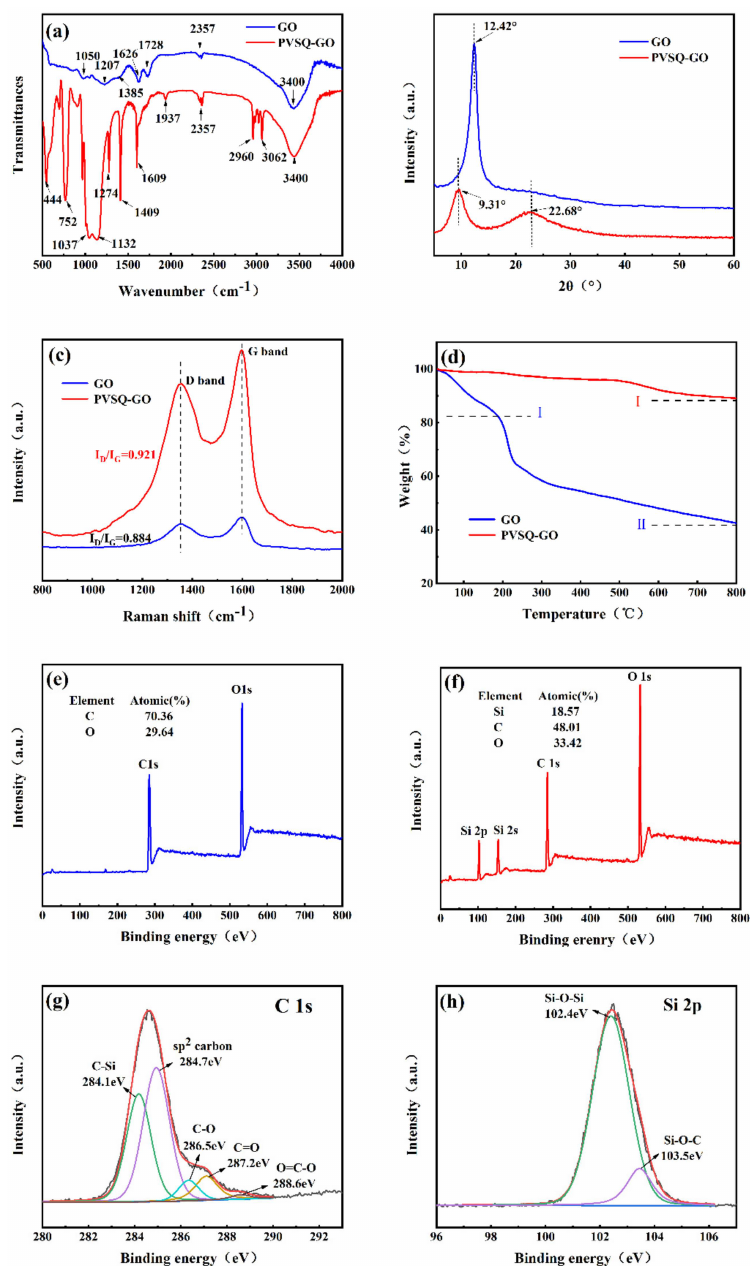
Figure 3. ( a ) FTIR, ( b ) XRD patterns, ( c ) Raman spectra, ( d ) TGA curves of GO and PVSQ-GO. ( e , f ) Survey X-ray photoelectronic spectroscopy (XPS) spectra of GO and PVSQ-GO, ( g , h ) C 1 s and N 1 s spectrum of